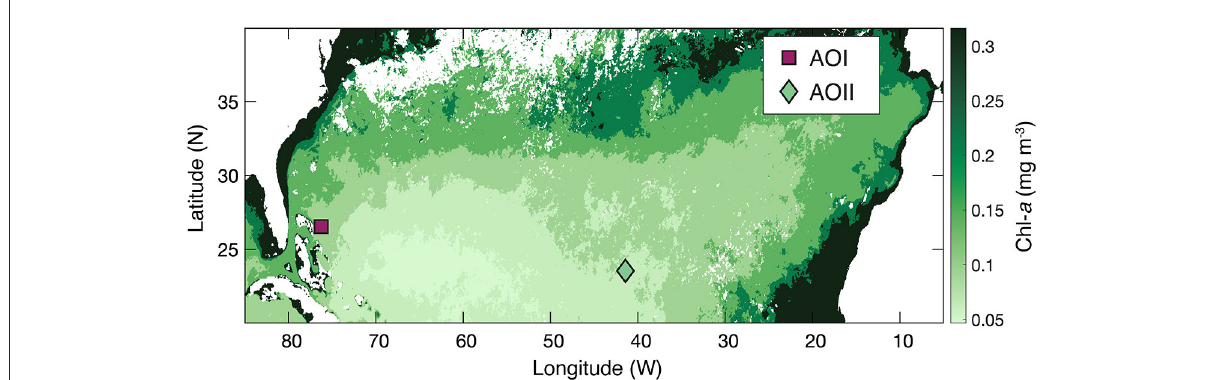
FIGURE1 A map of the North Atlantic Subtropical Gyre, with marked station locations for the study (see Table 1 for coordinates). The background is the mean satellite-derived chlorophyll- a (Chl- a ), averaged for the months of January and February,